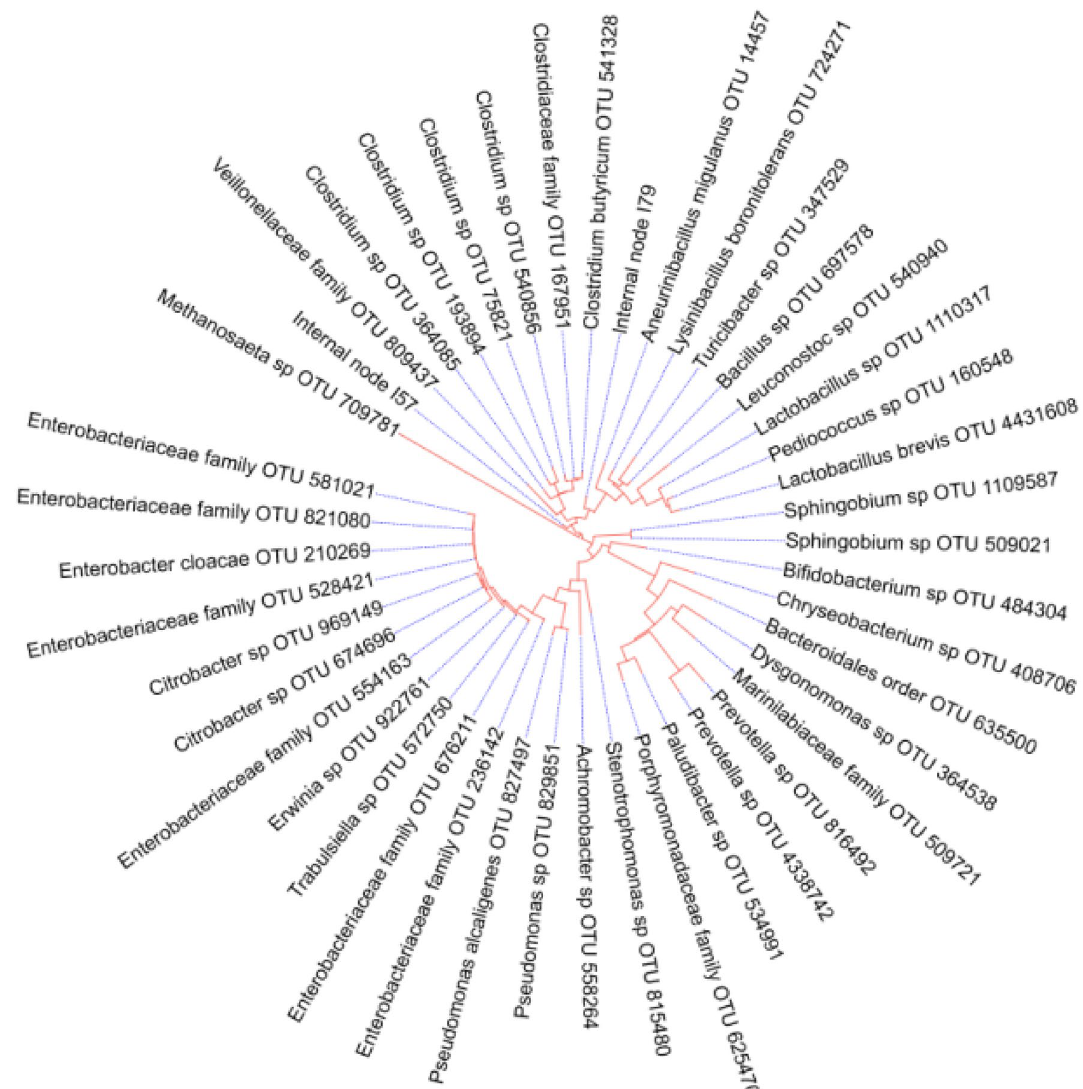
Figure 7. Phylogenetic analysis of distinctive electrogenic bacterial species used in air–cathode MFCs. A rooted phylogeniatc tree was consctructed using Mega-X